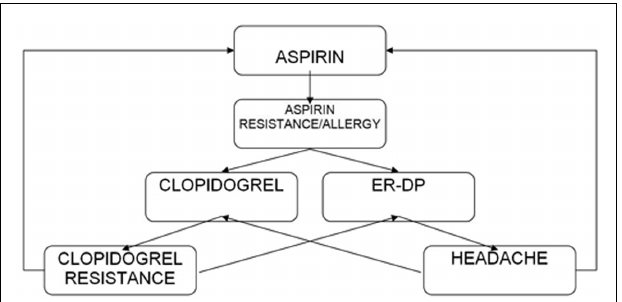
FIGURE 1 | Selection of individual antiplatelet agents